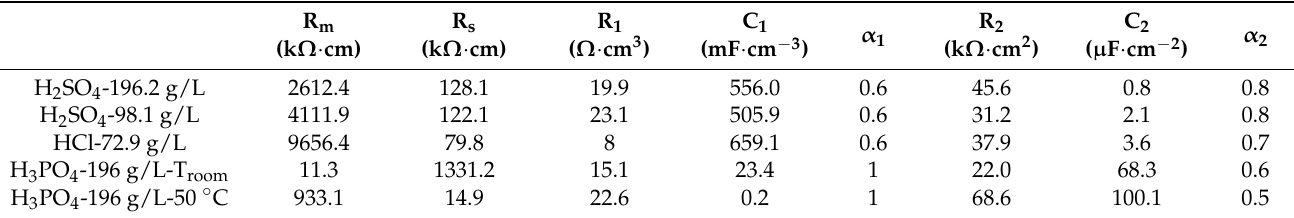
Table 6. Fitting parameters obtained from the impedance recorded in 0.1 M Na 2 SO 4 for the phosphate coatings developed after the pickling in the conventional inorganic